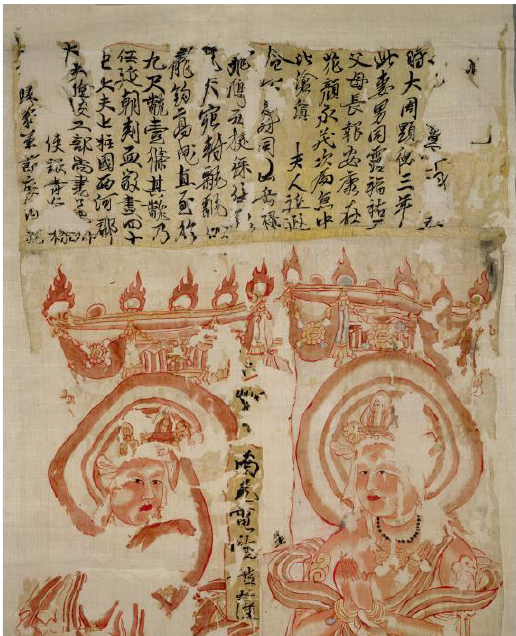
Figure 2. Details of Figure 1, showing Stein Painting 216’s inscription. © The Trustees of the British Museum.